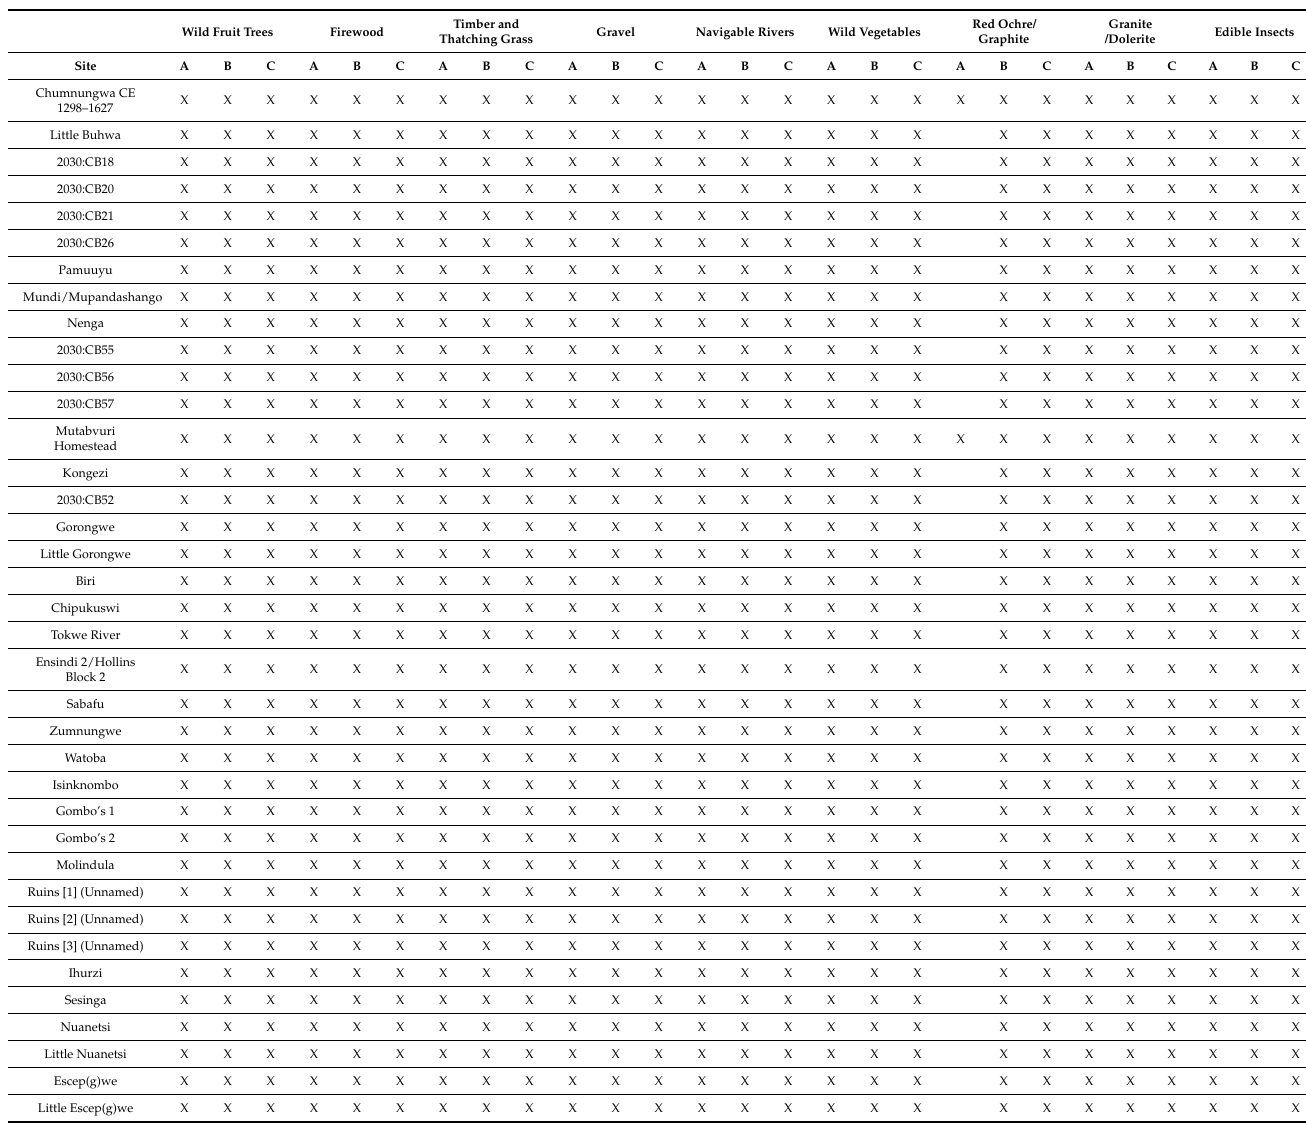
Table A2. Availability of wild foods, fuel, navigable rivers and raw materials for the crafting and construction of infrastructure within the catchment area of Zimbabwe tradition settlements recorded in